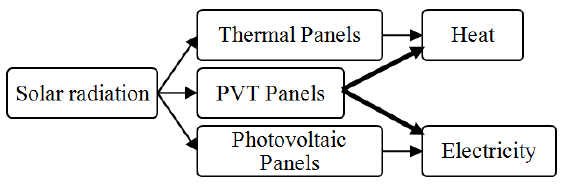
Figure 1. PVT energy diagram.